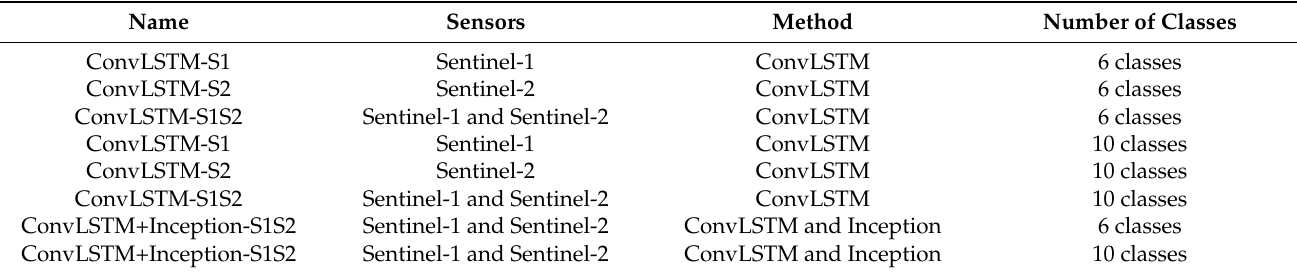
Table 4. List of experiments based on the methods